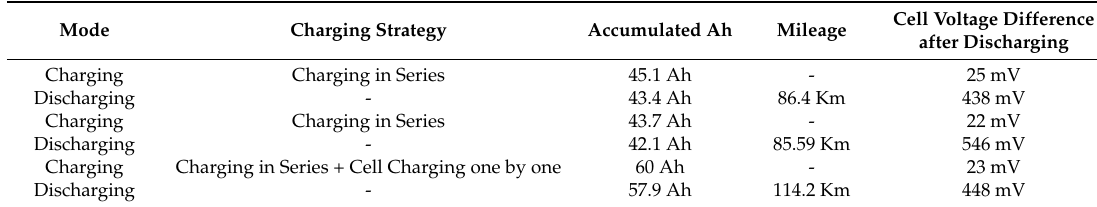
Table 2. Discharging results for three sets of